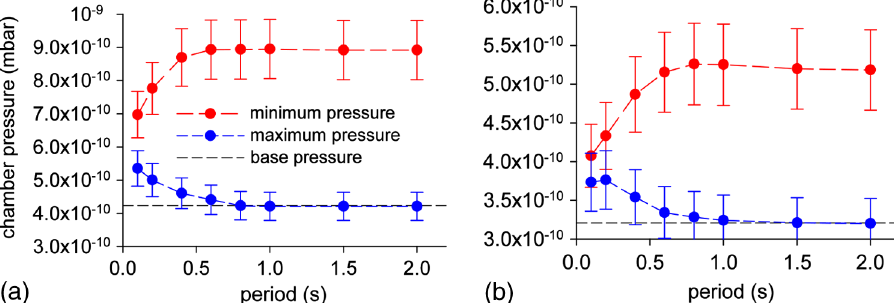
FIG. 13. Plot of pressure at (a) differential chamber and (b) dump chamber versus pulse valve period; the duty cycle of the pulsed valve is 50%, the pressure at the pulsed valve is 2 bar, and helium is the gas used.